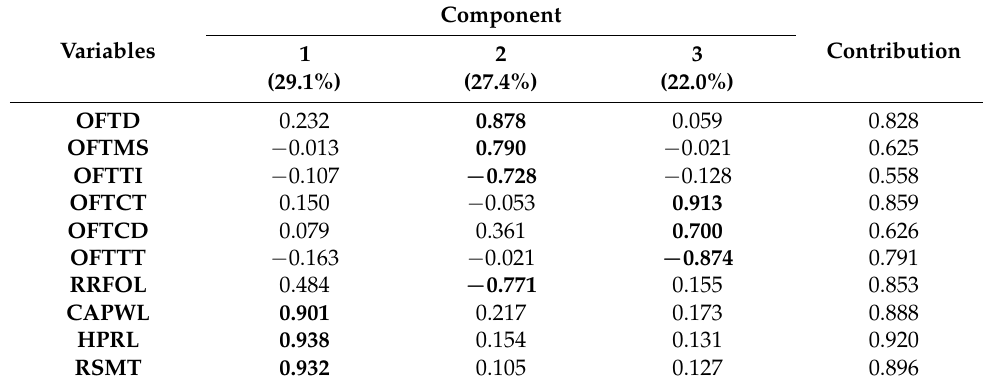
Table 2. Rotated (Varimax-Kaiser normalization) matrix of extracted components with eigenvalue > 1.